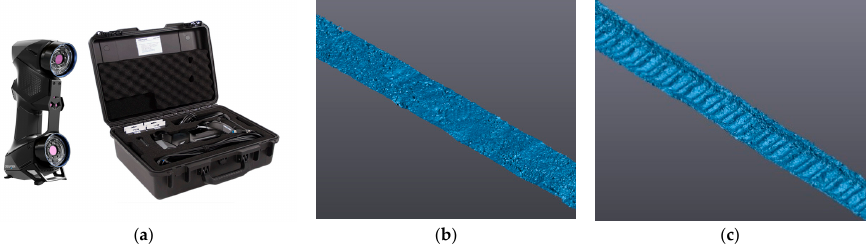
Figure 19. Sloped terrain appearance at bottom of track. ( a ) 3D scanner ; ( b ) Before testing; ( c ) After testing.